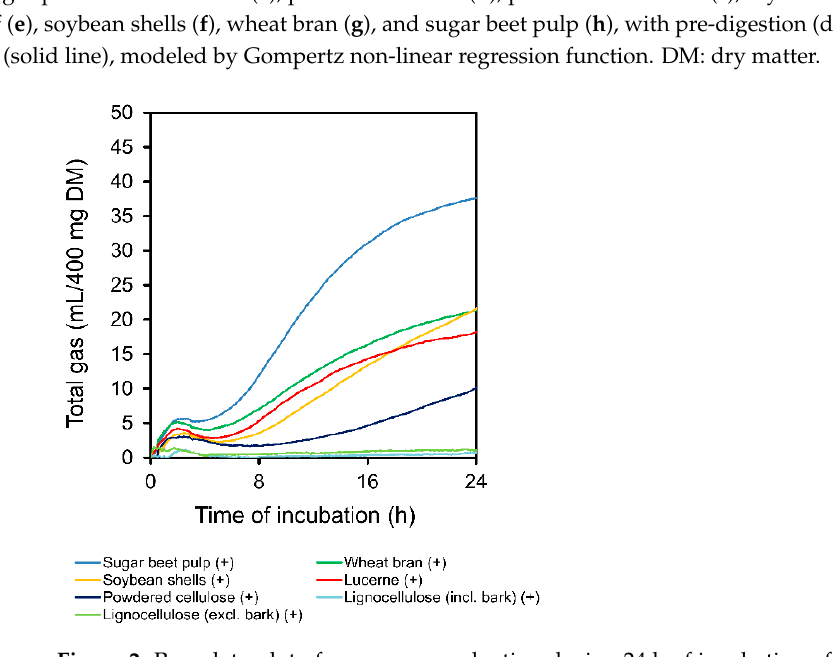
Figure 2. Raw data plot of mean gas production during 24 h of incubation of fibers and fiber-rich feeds, which had been pre-digested (+). DM: dry matter.